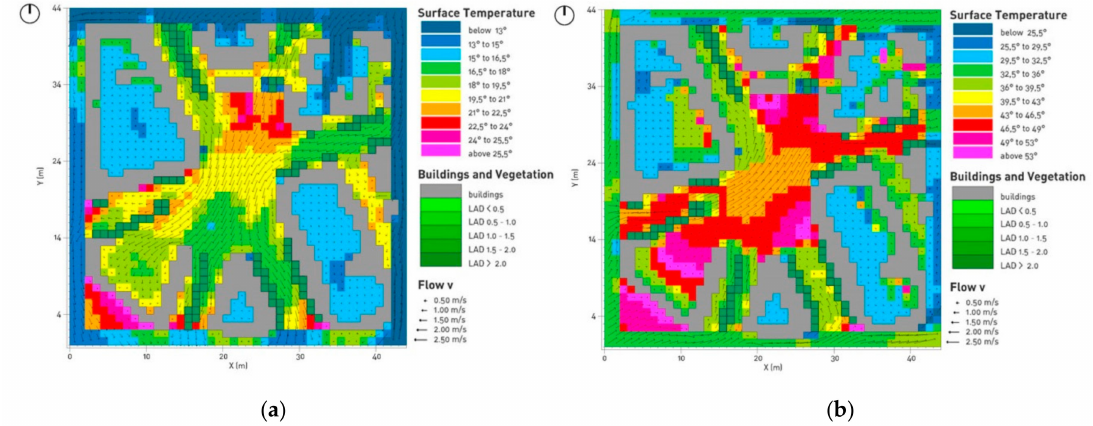
Figure 5. Piazza Bainsizza surface temperature and wind analysis: ( a ) Winter simulation based on 21st December at 3:00 p.m.; ( b ) Summer simulation based on 21st June at 3:00 p.m. (analysis software: ENVI-met